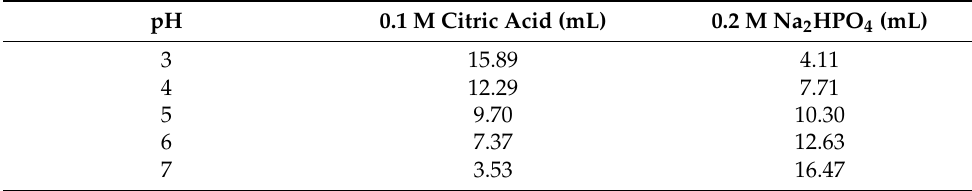
Table 3. Preparation of McIlvaine buffer solutions